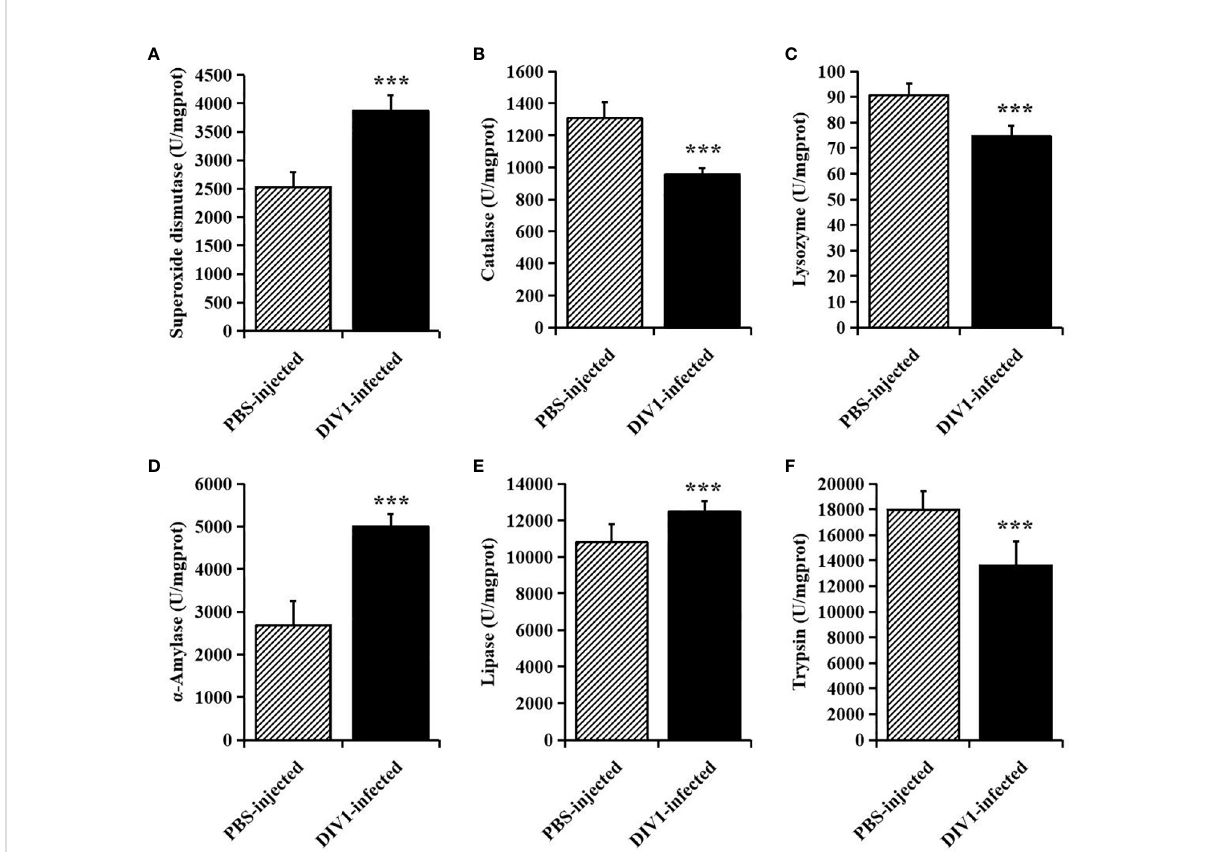
FIGURE 2 The activities of immune and digestive enzymes in the intestine of M. japonicus (mean ± SD). (A) Superoxide dismutase (SOD). (B) catalase (CAT). (C) lysozyme (LYZ). (D) a -Amylase. (E) lipase (LPS) and (F) trypsin (TPS). The statistically signi fi cant differences between the two groups were calculated by Student ’ s t -test (*** p <